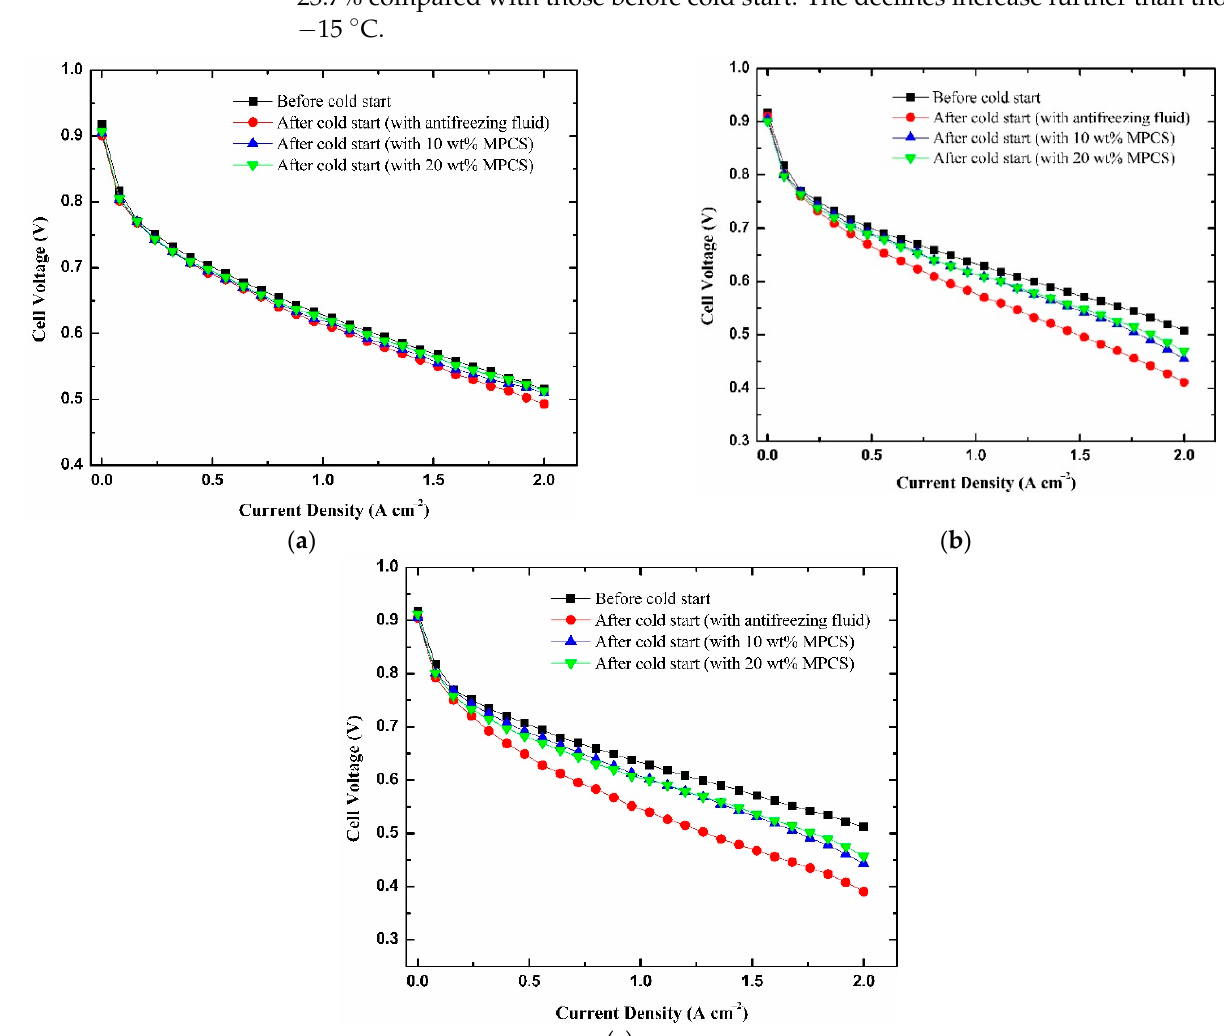
Figure 14. The polarization curves of PEMFC before and after cold starts at different mass concentrations of antifreeze fluid ( a ) − 10 °C ( b ) − 15 °C ( c ) − 20 °C.